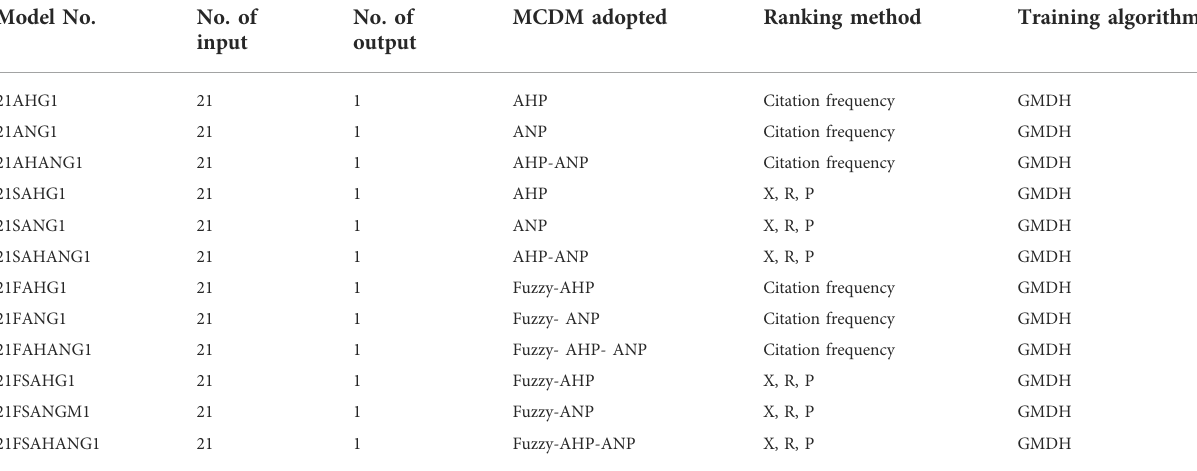
TABLE 2 Table showing the features of the twelve development models. Model No.